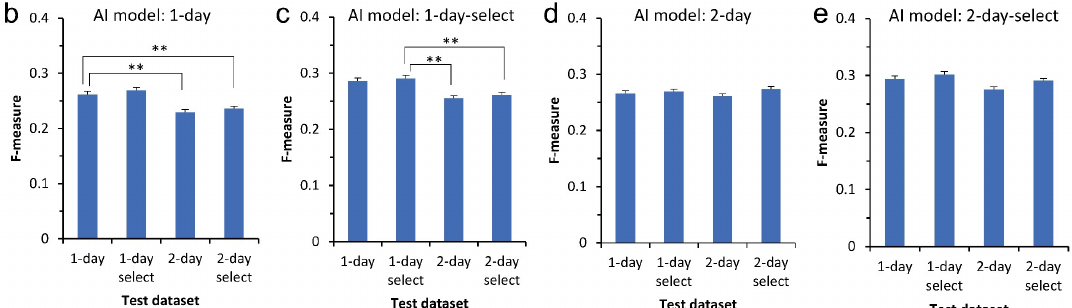
Figure 3. Indication of the versatility of AI models. ( a ) The AI models output examples for test datasets. Numbers in output images were F-measure values between output and target images. Bars = 100 µ m. ( b ) Evaluation of the capability of AI was performed using F-measure values for test datasets ( b – e ). AI model trained using dataset of ( b ) 1-day, ( c ) on1e-day-selected, ( d ) 2-day, and ( e ) 2-day-selected. Mean ± S.E.M., n = 1000. ** p < 0.01.